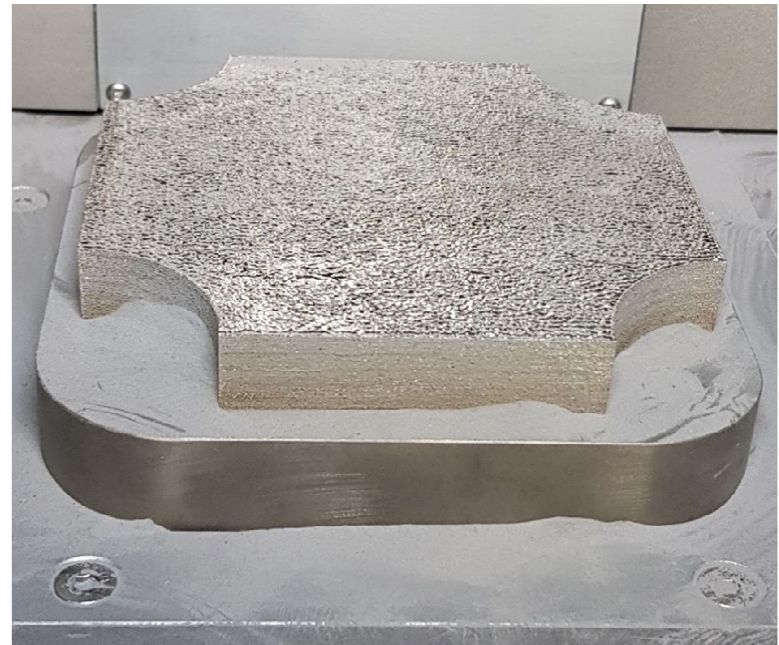
Figure 3. Sample panel on the SLM 125 HL’s substrate plate.